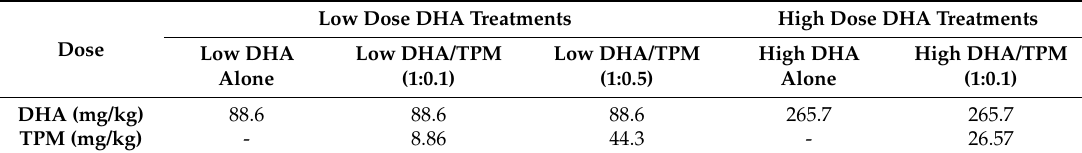
Table 1. Treatment formulations administered to rats. Treatments were divided into low and high doses of DHA and used in combination with two different ratios of TPM. Doses were made up in a canola vehicle and averaged 1 g total per 250 g